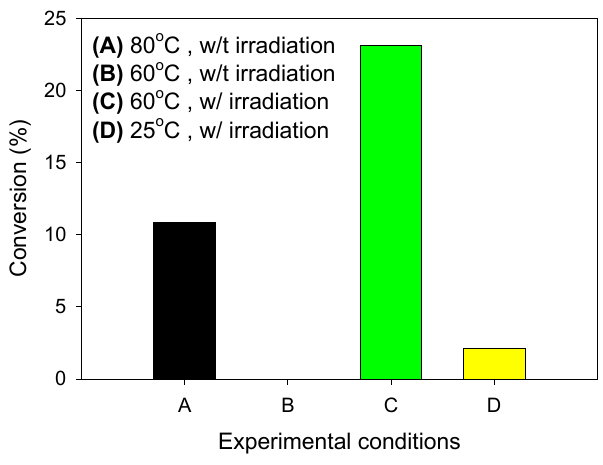
Figure 5. Catalytic and photocatalytic epoxidation of cyclohexene over V 0.25 Ti 2